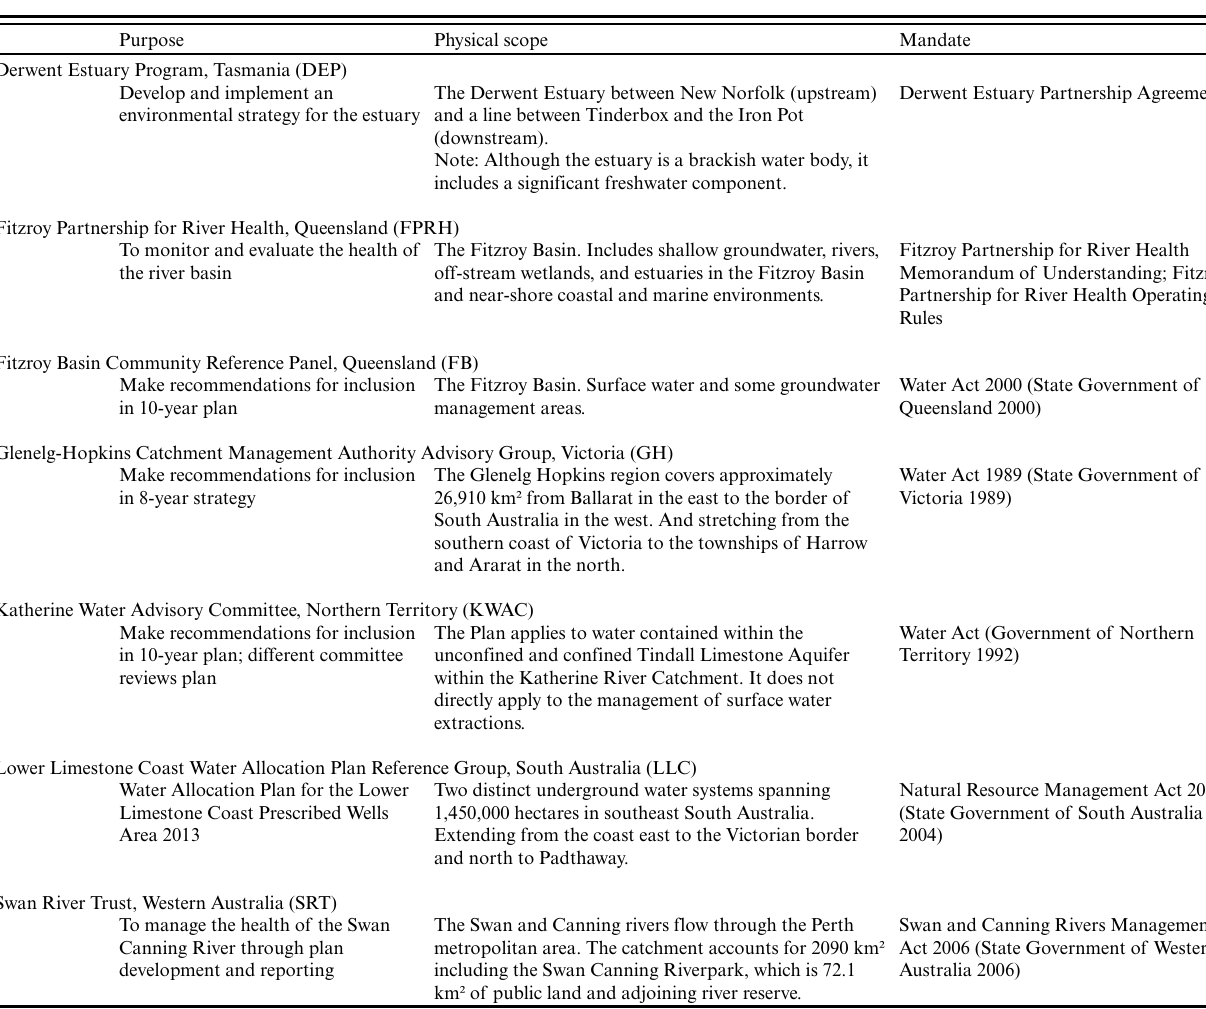
Table 1 . Descriptive context of the Australian collaborative